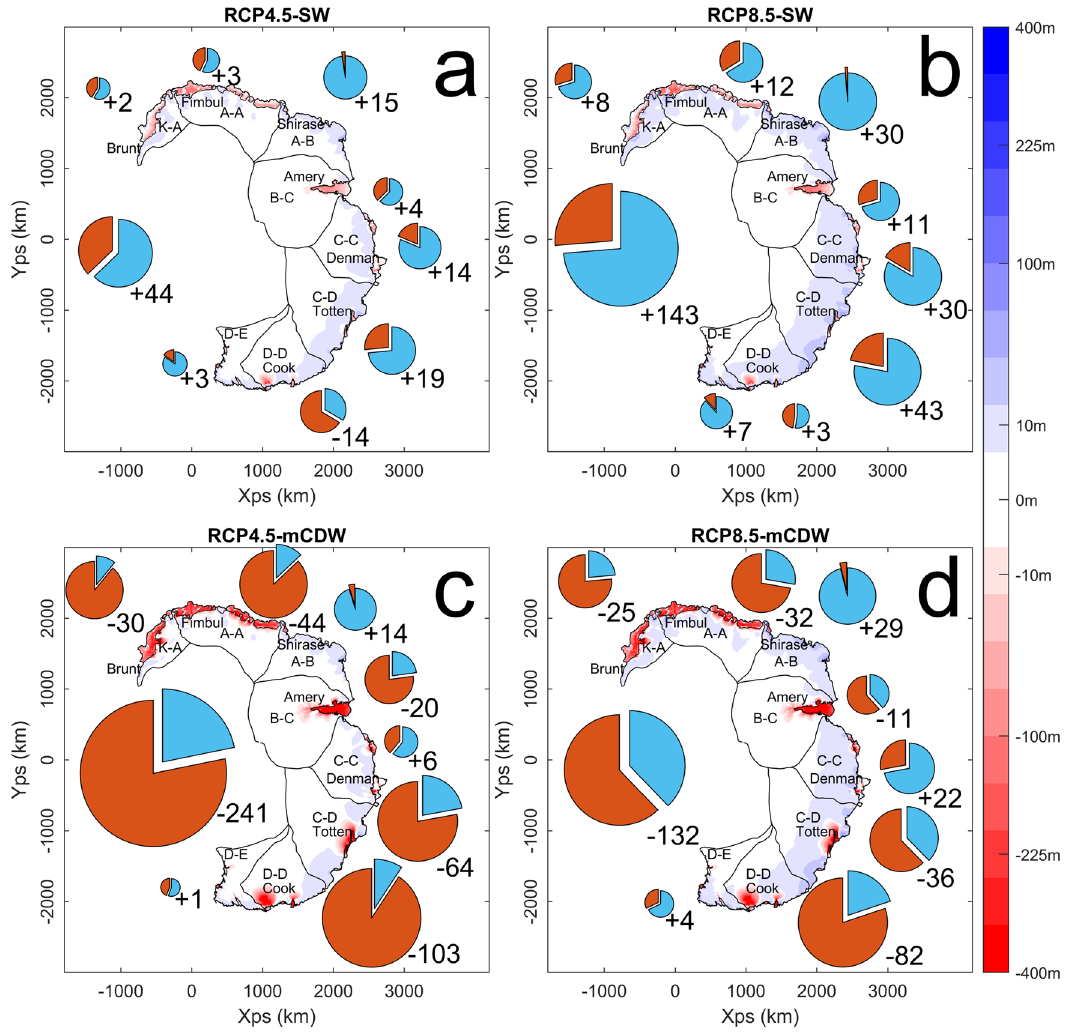
icethicknesschange(colours) after 200yearsrelativetotheunforcedscenario for a RCP4.5-SW, b RCP8.5-SW, c RCP4.5-mCDWand d RC8.5-mCDWclimatescenarios (Representative Concentration Pathway, Shelf Water and Modi fi ed Circumpolar Deep Water respectively). Regions correspond to the IMBIE 2016 catchments 49